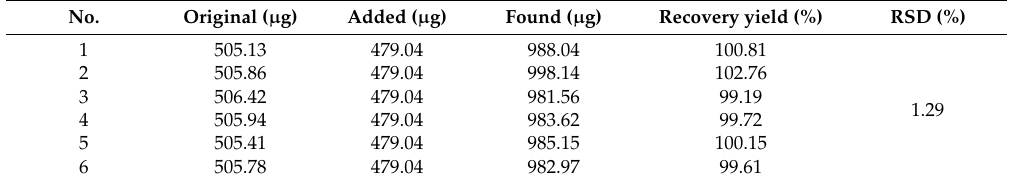
Table 4. The recovery rate of the Cy-3-glc in bilberry